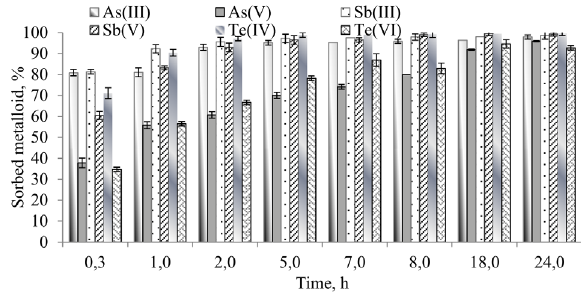
Figure 8: Influence of competing substances on sorption of Sb. Sorbent – Fe-modified peat (from the Gagu Bog), concentration of competing ions – 25 mg L -1 , C – 12.5 mg L -1 , sorption time 24 h at HA room temperature.